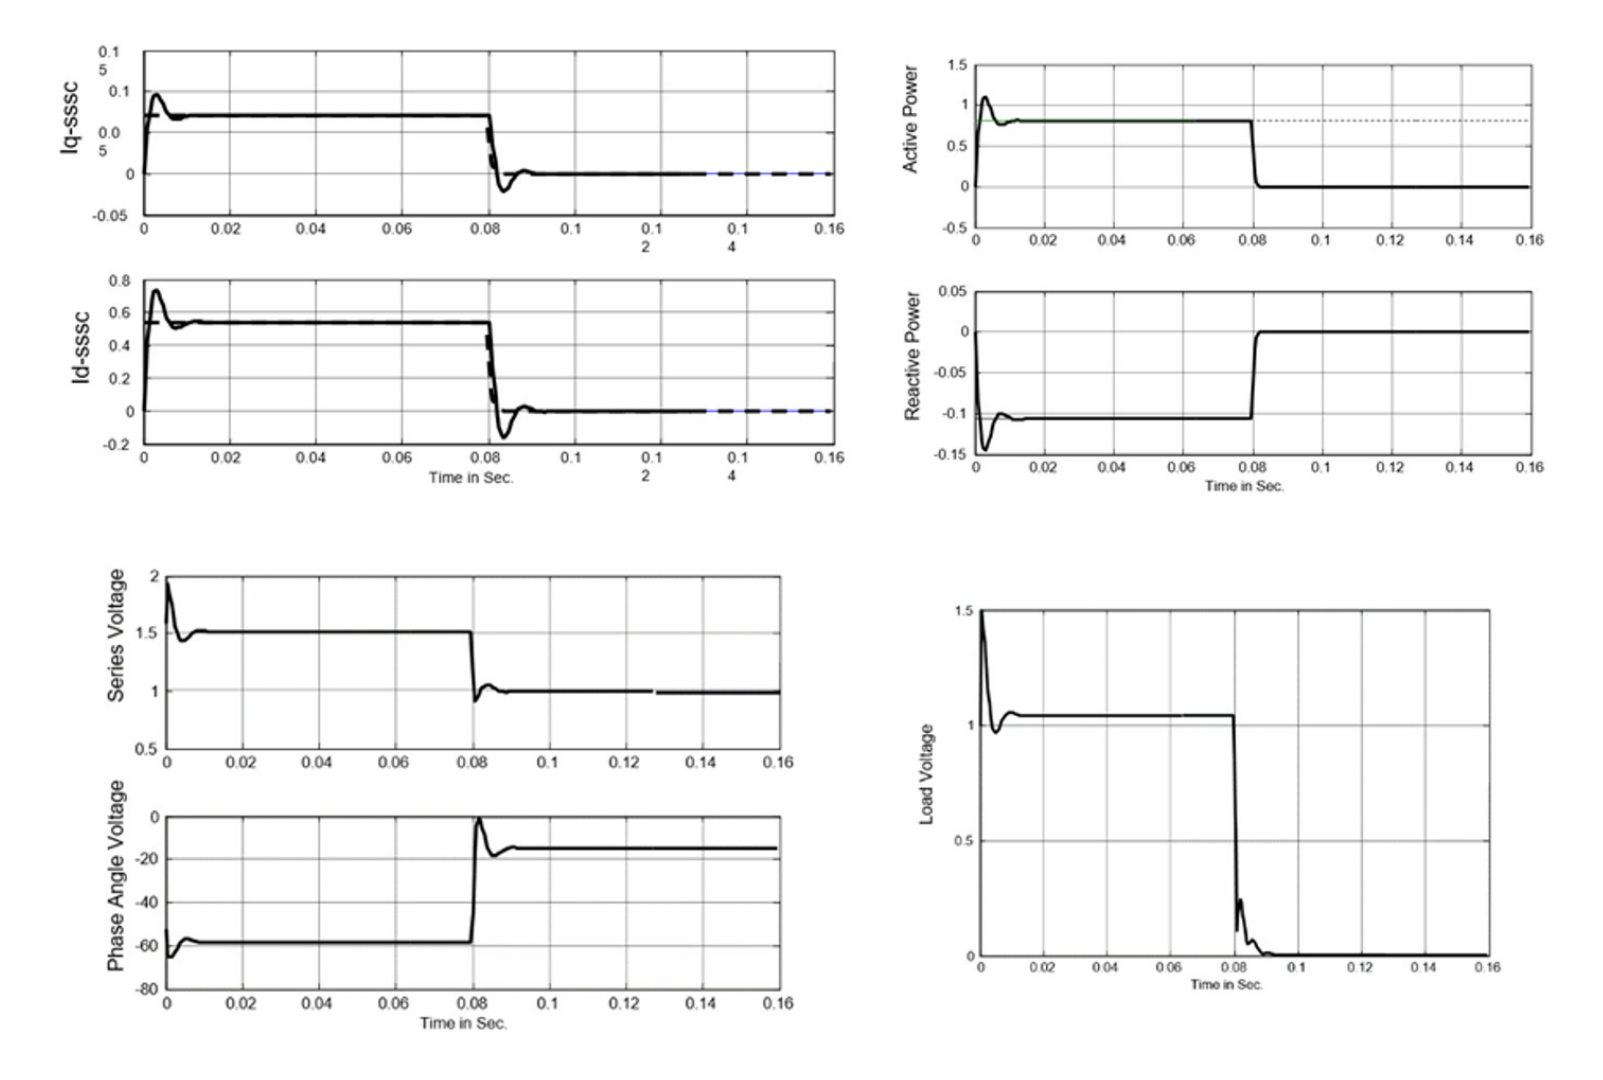
Figure 14. The transient performance of the SSSC in case of Voltage Variation with